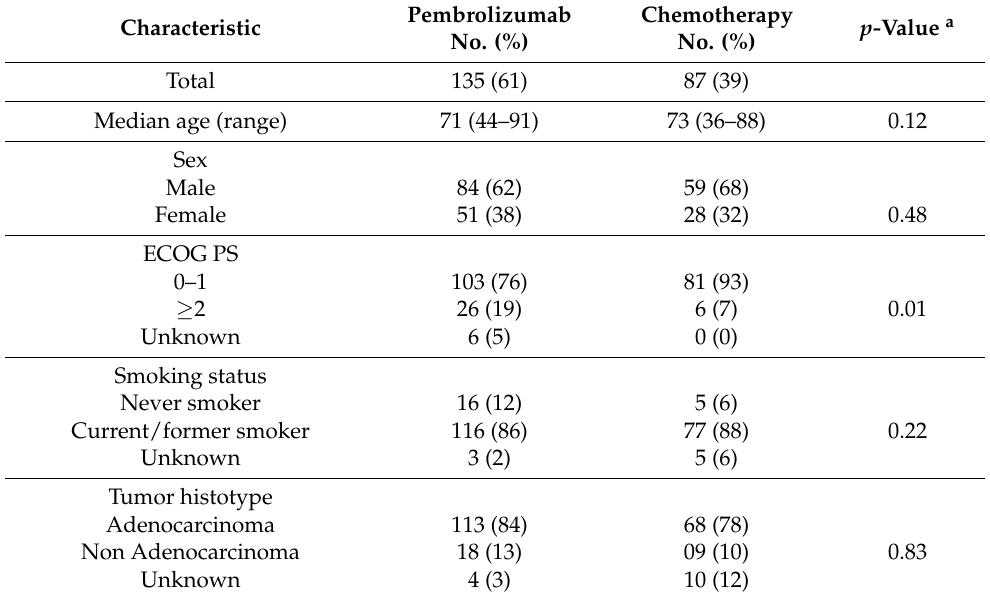
Table 1. Patient characteristics by treatment